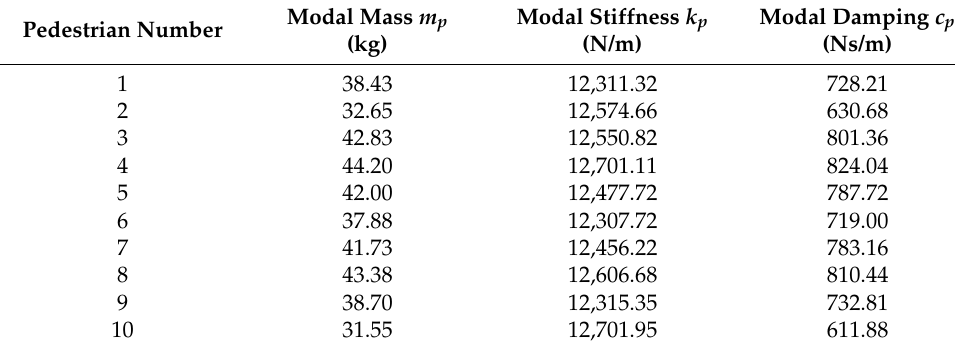
Table 2. Reference values of pedestrian